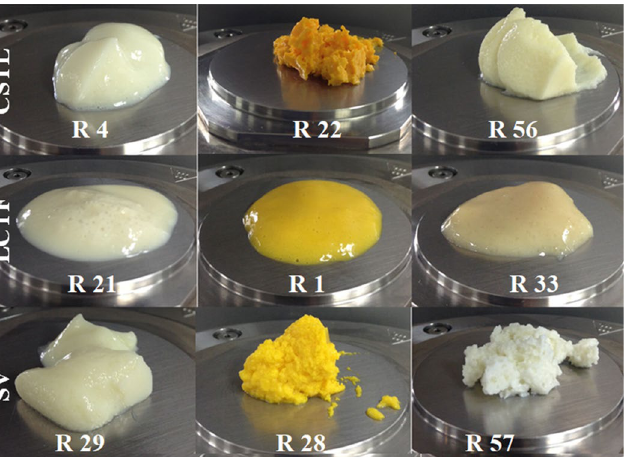
Figure 2. Oleogels formed with different WP and oils by MF. Rows: 1. WP1, 2. WP2 and 3.WP3, columns: 1. SO, 2. HOPO, 3. VCO. R corresponds to the run (emulsion) of the experimental